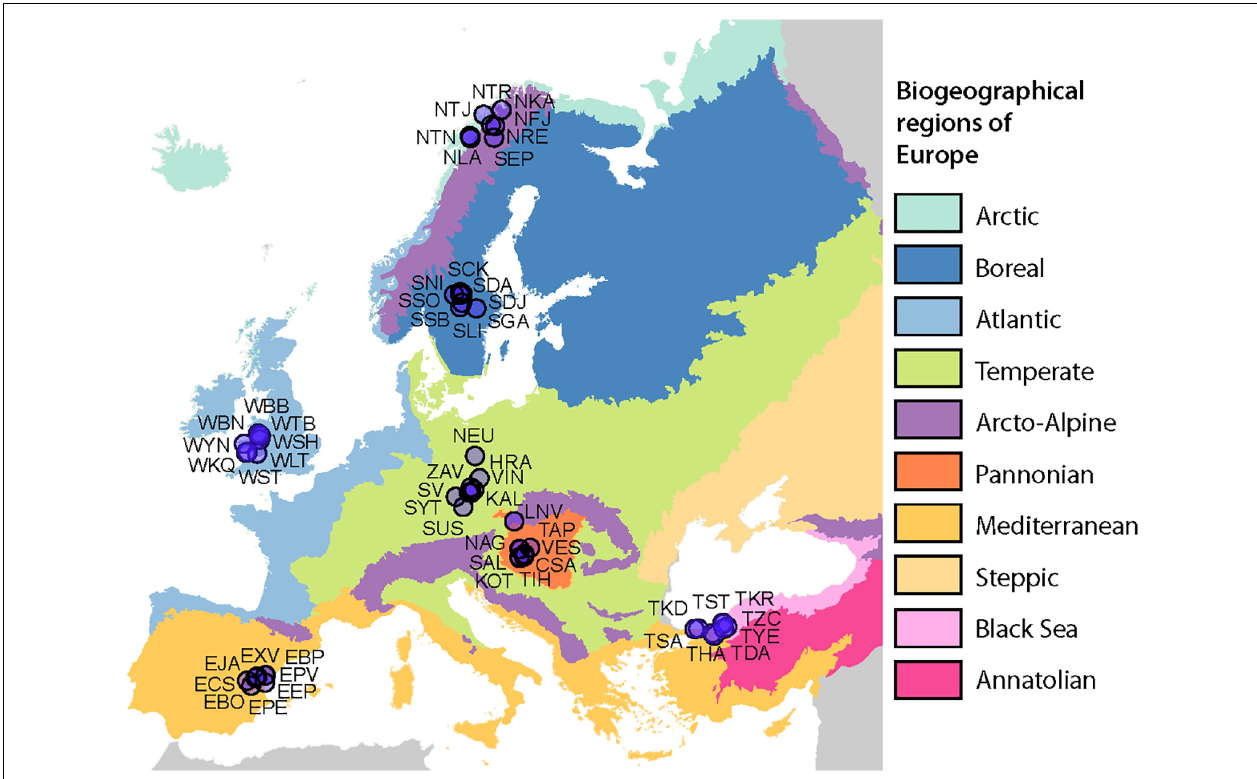
FIGURE 1 | Sampling design. Eight sites were sampled in seven of the biogeographical regions of Europe. Map copyright holder: Council of Europe (CoE), Directorate-General for Environment (DG ENV).